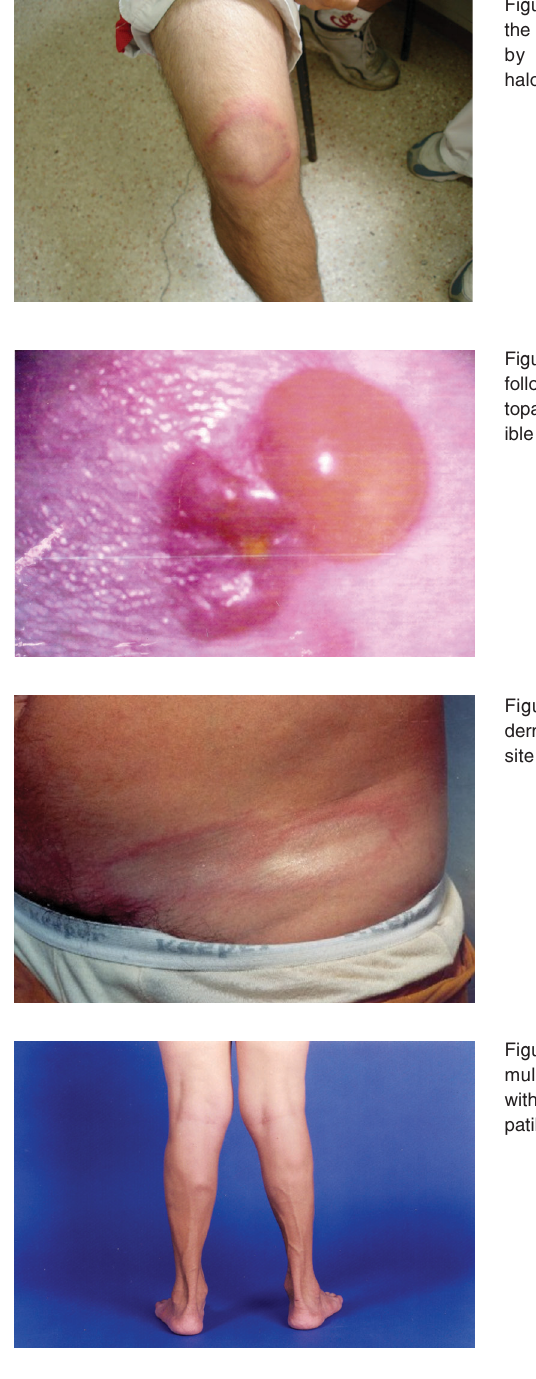
Figure 5. Acute skin lesion at the tick bite site, characterized by expansive erythematosus halo.